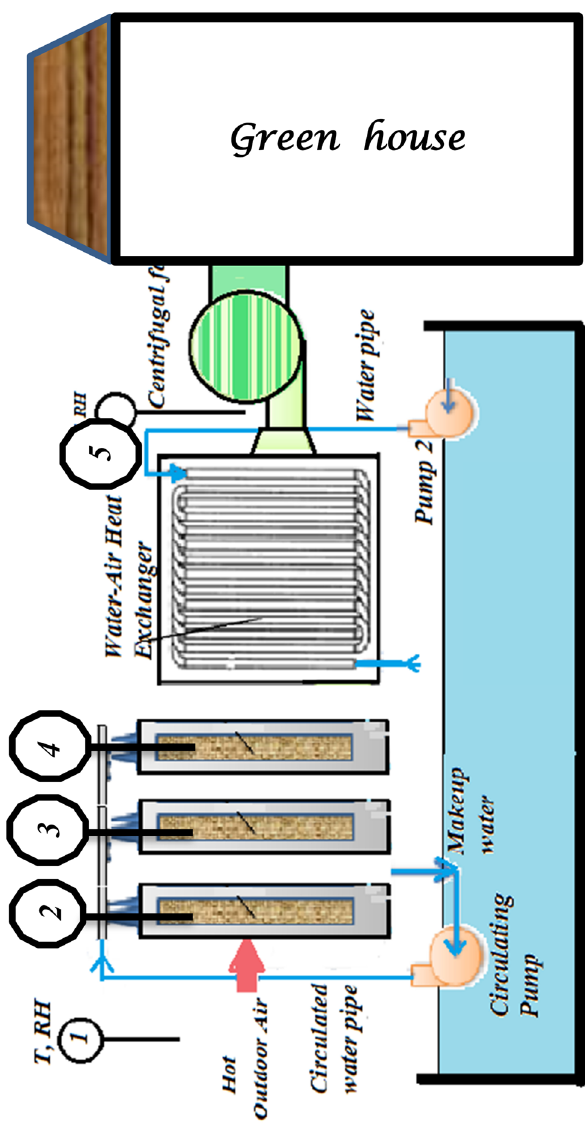
Figure 3: Experimental rig.